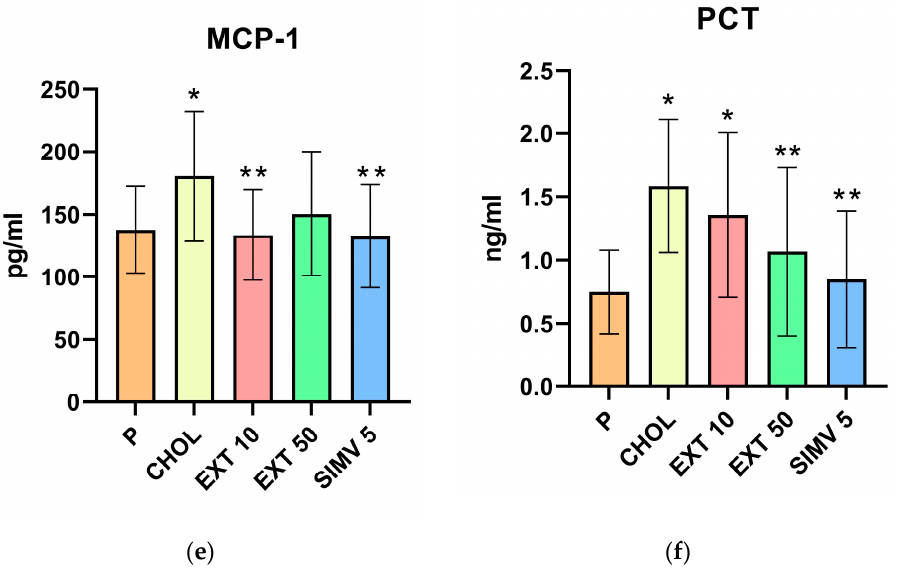
Figure 2. Serum levels of VCAM-1, ICAM-1, CRP, PON-1, MCP-1, and PCT by ELISA method. ( a ) VCAM-1, ( b ) ICAM-1, ( c ) CRP, ( d ) PON-1, ( e ) MCP-1, and ( f ) PCT. P—standard chow; CHOL—standard chow + 1% cholesterol; EXT 10—standard chow + 1% cholesterol + Cornelian cherry extract 10 mg/kg bw; EXT 50—standard chow + 1% cholesterol + Cornelian cherry extract 50 mg/kg bw; SIMV 5—standard chow + 1% cholesterol + simvastatin 5 mg/kg bw Values are presented as mean ± SD. * p < 0.05 vs. P. ** p < 0.05 vs. CHOL.